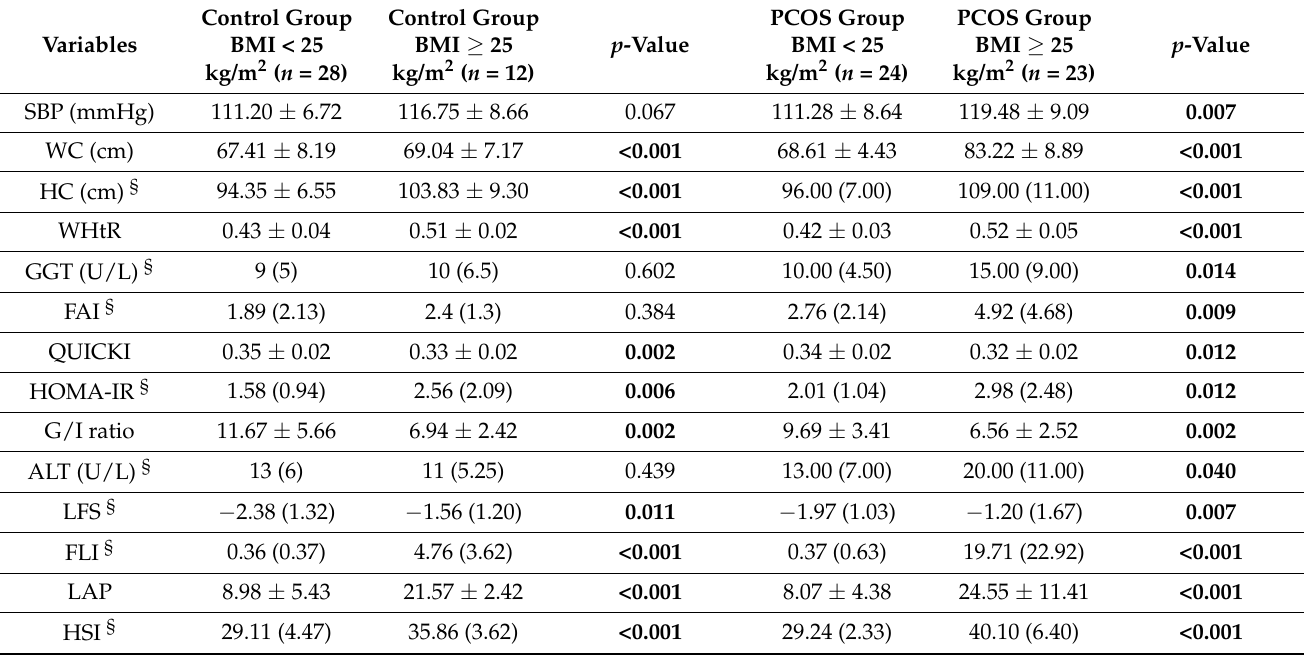
Table 3. Anthropometric, biochemical/hormonal parameters, IR, and liver steatosis indices of PCOS and control groups stratified by